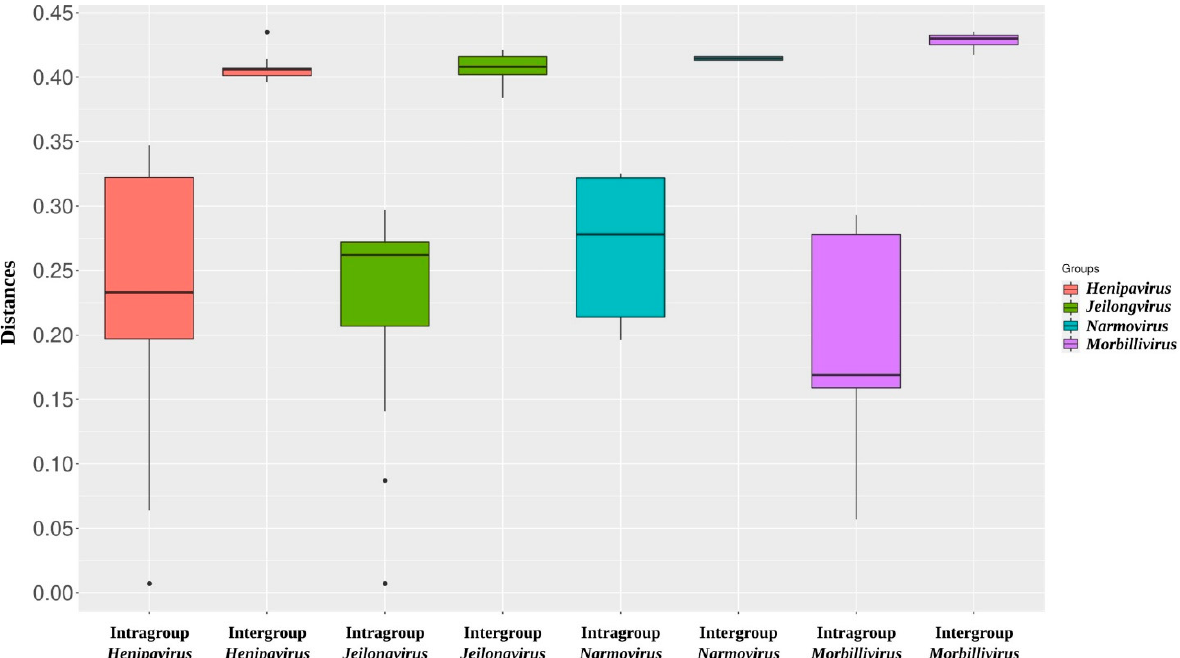
Figure 4. Boxplot graph of amino acid divergence among the members of the four genera closest to PBV ( Henipavirus , Jeilongvirus , Narmovirus , and Morbillivirus ) against each other (intragroup), and between them and PBV (intergroup).